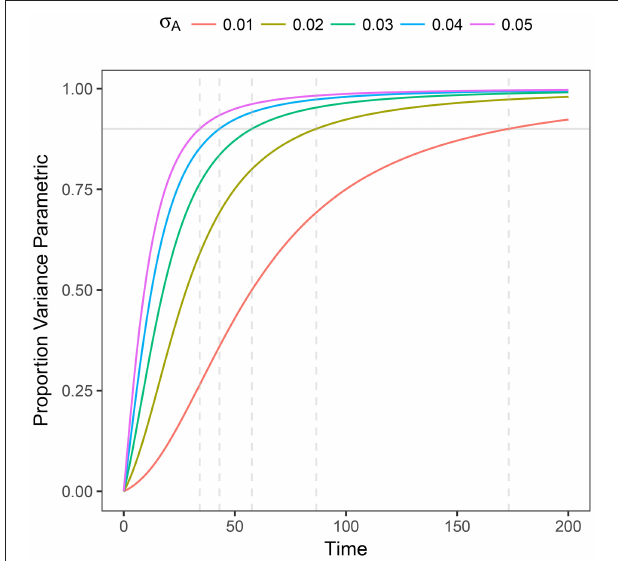
FIGURE 2 | Plot of R 2 as a function of time for heterogeneous stochastic exponential growth. Each line shows R 2 for the specified level of σ A assuming µ A = 0.1. The horizontal gray line indicates 90% of the variance being due to parametric heterogeneity; the dashed vertical gray lines indicate the time at which each line reaches 90%.